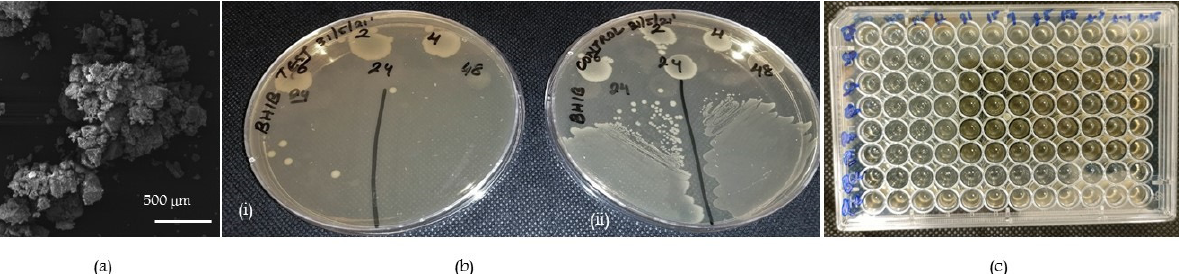
Figure 1. ( a ) Scanning electron microscopy image of copper-doped phosphate glass particles at 100× magnification. ( b ) Representative picture of preliminary test of antibacterial activity (i) Test— E. faecalis exposed to 500 mg/mL CDPG at different time points in hours (ii) Control— E. faecalis not exposed to 500 mg/mL CDPG. ( c ) Representative image for determination of MIC by broth microdilution method. All six bacterial strains showed a uniform MIC of 125 mg/mL.